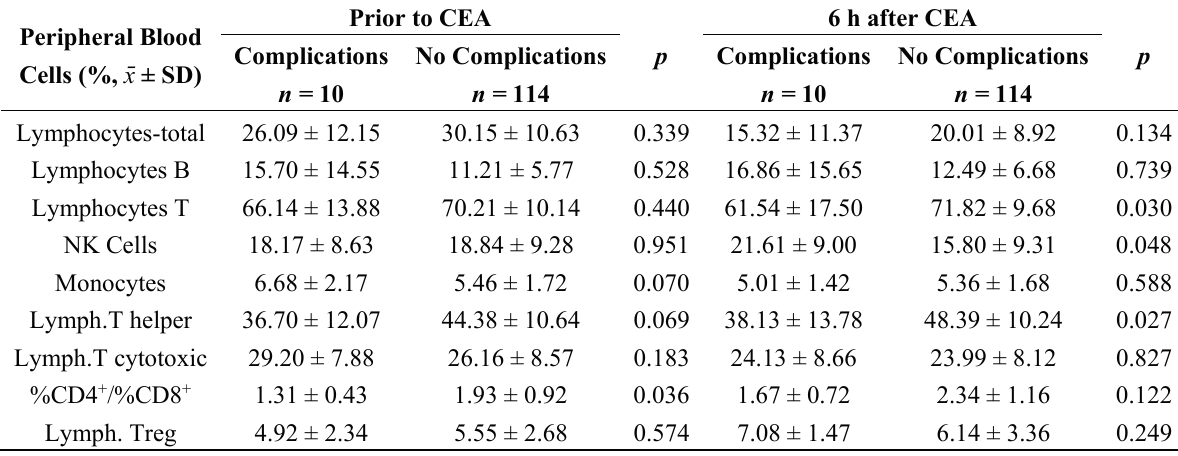
Table 4. Peripheral blood cells subgroups analysis prior to carotid endarterectomy (CEA) procedure and 6 h post CEA for group with postoperative 30-days complications and without